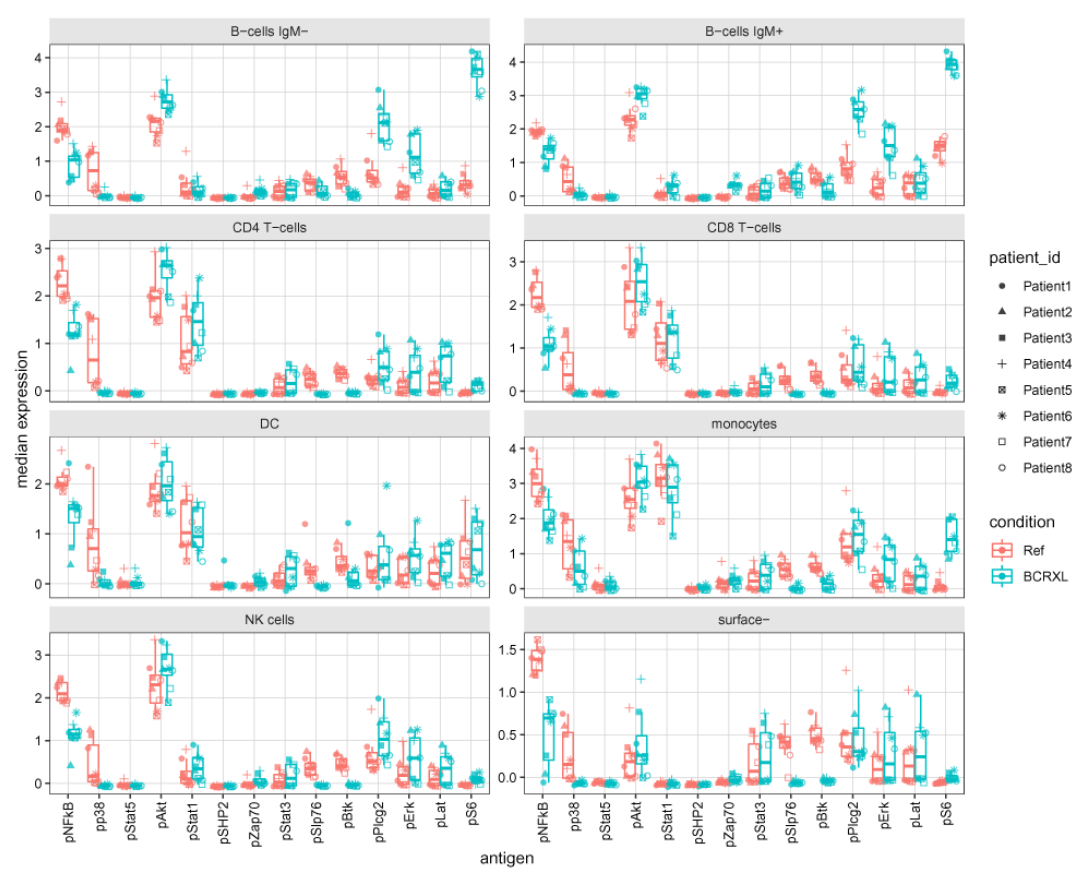
Figure 23. Median (arcsinh-transformed) expression of 14 signaling markers (x-axis) across the 8 identified PBMC cell populations (individual panels). Values for the two conditions are indicated with different colors: red for the unstimulated (Ref) and blue for the stimulated with BCR/FcR-XL (BCRXL) samples. Values for each patient are indicated with different shape. The 8 cell populations are a result of manual merging of the 20 FlowSOM